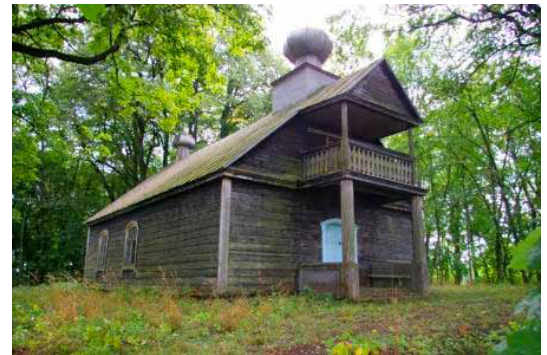
fig. 2. Bobriškis Church of Old Believers